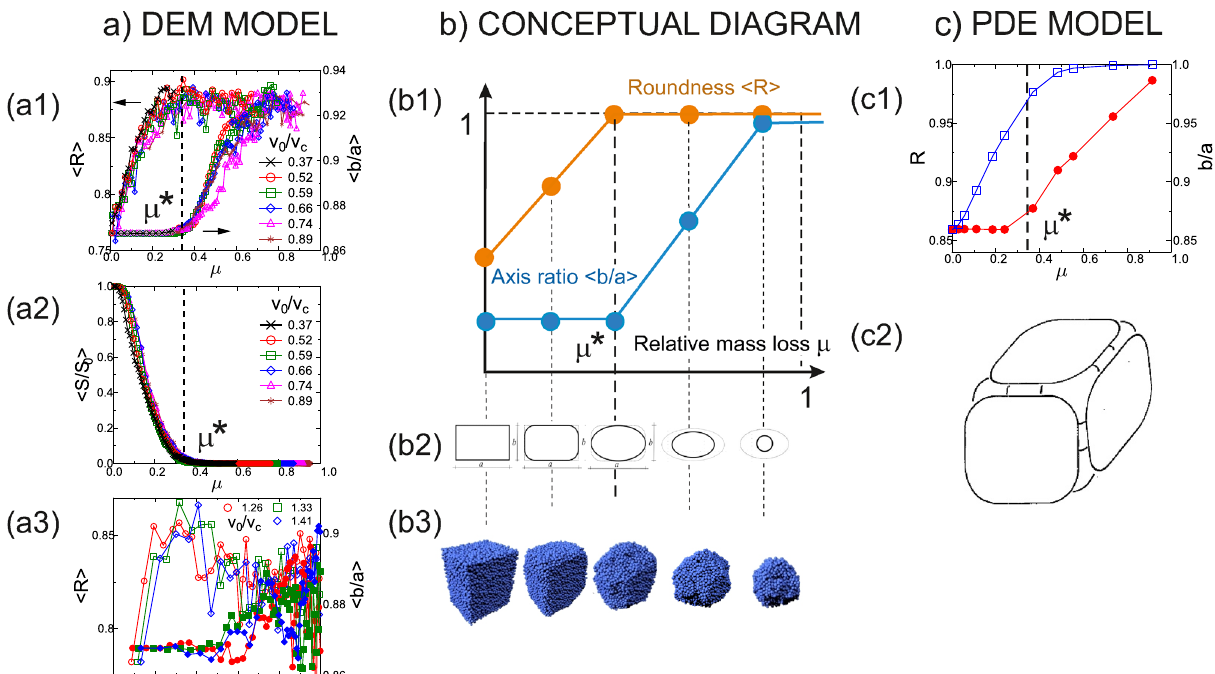
Figure 7. Geometric shape evolution as a function of the relative abraded mass µ . ( a ) DEM simulations: ( a1 ) Abrasion energy phase: evolution of the average circularity (cid:31) R (cid:30) and axis ratio (cid:31) b / a (cid:30) . Observe two geometric phases: phase 1 with approximately constant (cid:31) b / a (cid:30) followed by phase 2 with approximately constant (cid:31) R (cid:30) . Transition at µ ∗ ≈ 0.34 . ( a2 ) Abrasion energy phase: evolution of intact surface ratio S / S 0 . Transition between phases at µ ∗ ≈ 0.34 . ( a3 ) Cleavage phase: evolution of the average circularity (cid:31) R (cid:30) (open symbols) and axis ratio (cid:31) b / a (cid:30) (filled symbols). Observe absence of smooth evolution. ( b1 ) Schematic, bilinear approximation of two-phase geometric evolution of axis ratios and roundness. ( b2 ) Schematic side view of abrading cuboids, projected along the shortest ( c ) axis. ( b3 ) Snapshots of DEM simulations. ( c ) PDE model results: (c 1) Evolution of circularity R and axis ratio b / a 9 . Observe two geometric phases: phase 1 with approximately constant b / a followed by phase 2 with approximately constant R . ( c2 ) Hand-drawn sketch by R. Hamilton 46 predicting phase 1 characterized by nonzero intact surface